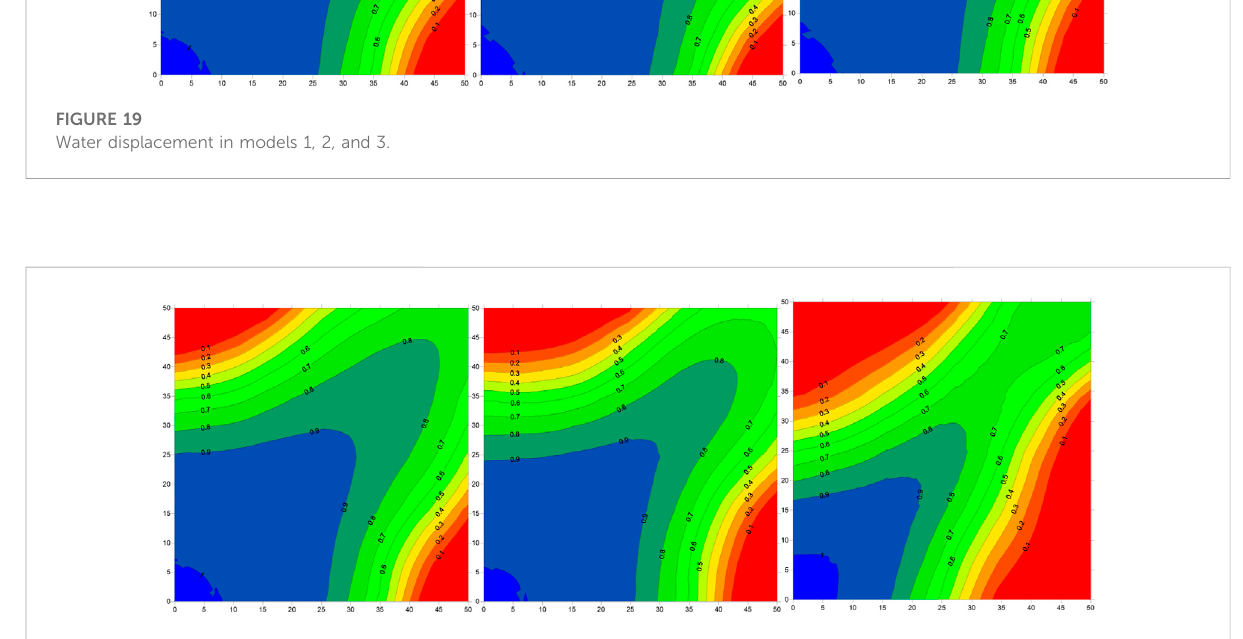
FIGURE 20 Water displacement in models 1, 4, and